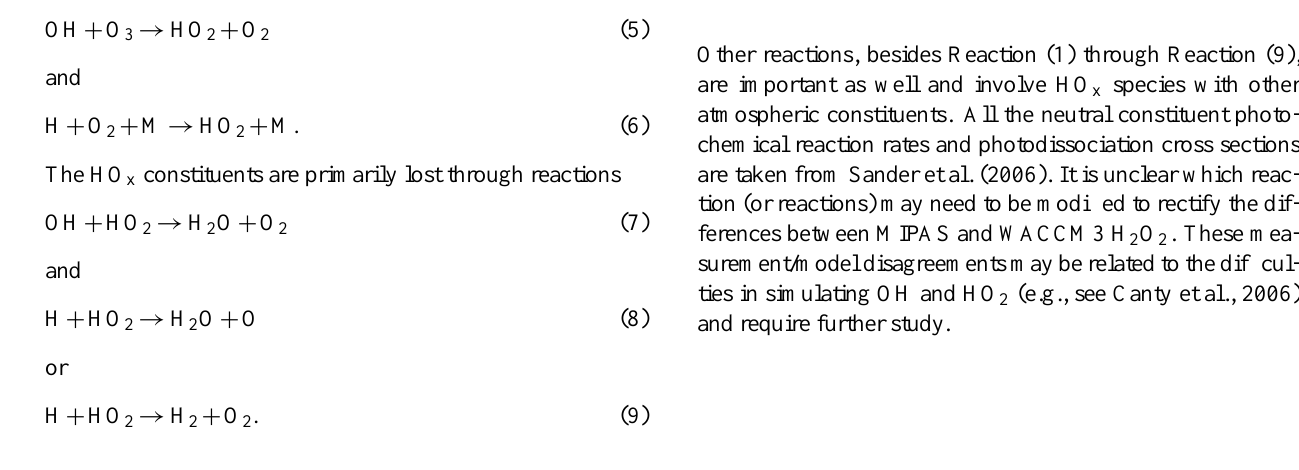
Fig. 8. Daily averaged hydrogen peroxide (H 2 O 2 ): Envisat MI- PAS measurements (top) and WACCM3 predictions (middle, bot- tom) for three days, 16–18 January 2005, in the 60–82.5 ◦ N band. The WACCM3 results are from the B average (middle) and a differ- ence between the B average and A average (bottom). The MIPAS averaging kernel (AK) was used to sample the WACCM3 results. The contour intervals are 10, 20, 40, 60, 80, 100, 150, 200, 250, and